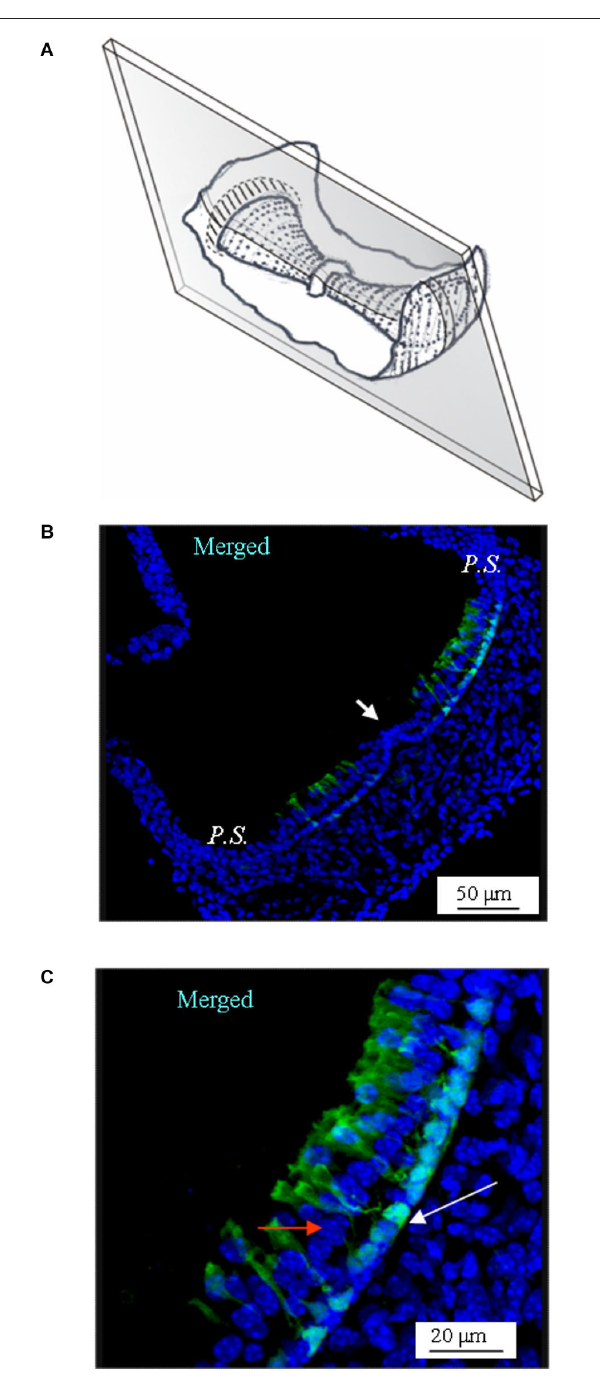
FIGURE 4 | GAD67 expression in longitudinal slices of the mouse vertical crista . (A) Schematic representation showing the plane of the slice. Note that the section is not through the center of the crista ( i.e., it is not a medial section). (B) Merged photomicrograph showing the expression of GAD67. Note the absence of GAD67 expression in the E.C. (white arrow). (C) Enlargement of a portion of the same image as in (B) , showing in better detail the shape and position of the cells expressing GAD67. The white arrow points at the nuclear region of a supporting cell. The red arrow points at a nucleus of a hair